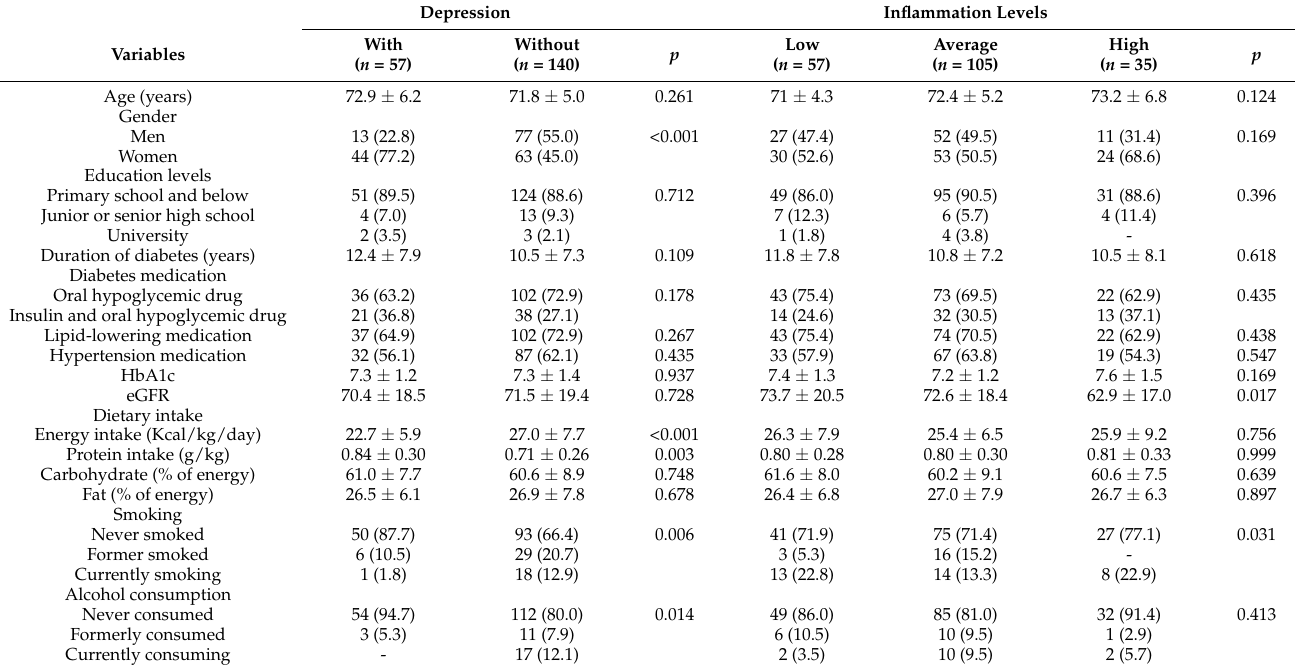
Table 1. Characteristics of older adults with type two diabetes, according to depression and inflam- mation levels 1